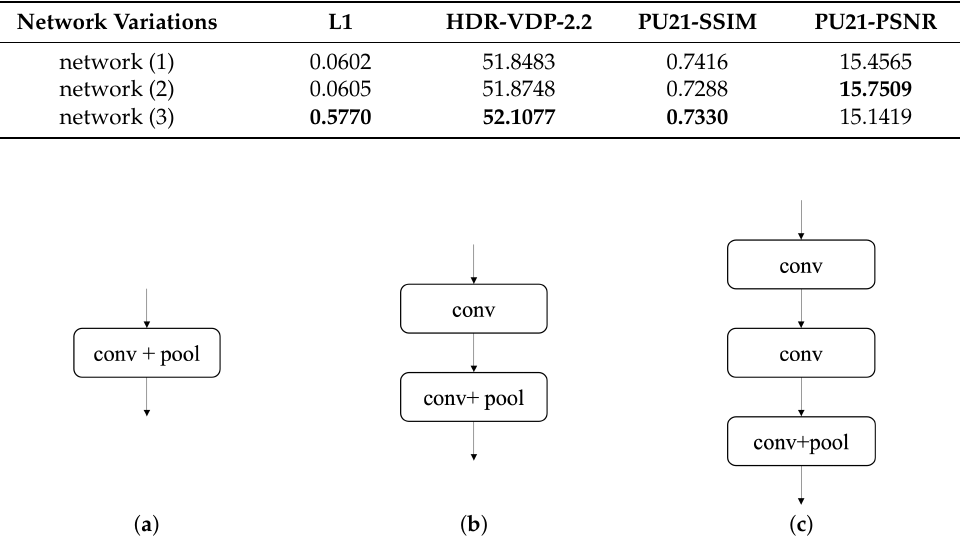
Figure 10. Block variations of the network. ( a ) Convolution layer followed by a pooling layer, ( b ) one non-pooling convolution layer and one convolution layer followed by a pooling layer (ours), and ( c ) two non-pooling convolution layers and one convolution layer followed by a